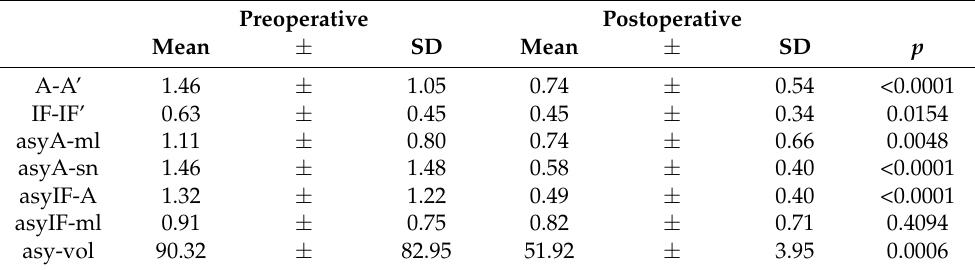
Table 1. Comparison of preoperative and postoperative (6 months after breast reduction) asymmetries. Preoperative